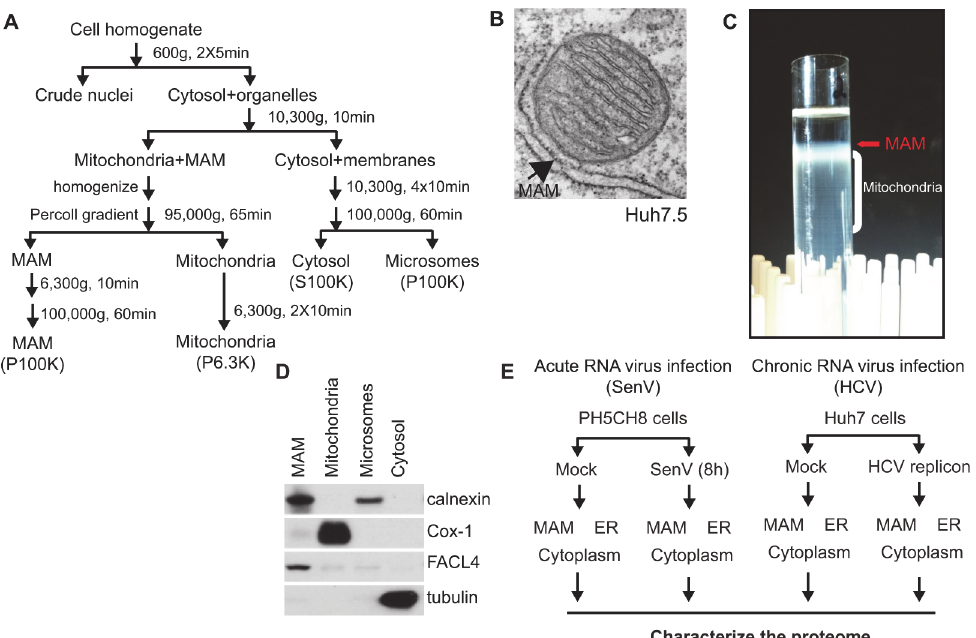
Fig 1. Experimental design for proteomic analysis of MAM fractions during RNA virus replication. (A) Percoll gradient biochemical fractionation scheme. (B) Electron micrograph of Huh7.5 cells. MAM is indicated by the arrow pointing to the membrane wrapping around a mitochondrion. (C) Percoll gradient illustrating a representative fractionation of PH5CH8 cells at the mitochondria/MAM isolation step. MAM and mitochondria were extracted from the gradient by a needle at the location indicated by the arrow and subjected to further purification. (D) Immunoblot analysis of biochemical fractions isolated from PH5CH8 cells. Fractionation markers: calnexin, ER; Cox-1, mitochondria; FACL4, MAM; tubulin, cytosol. (E) Experimental scheme for proteomic analysis.